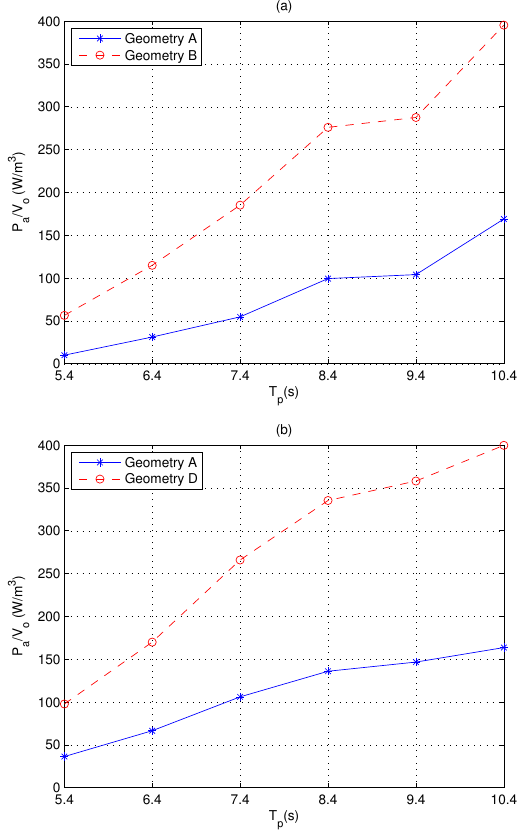
Figure 11. Power capture per unit volume when different geometries are adopted for constrained control: ( a ) LC and ( b ) PSOC. The PTO constraints are: k C = 0.75, F C =